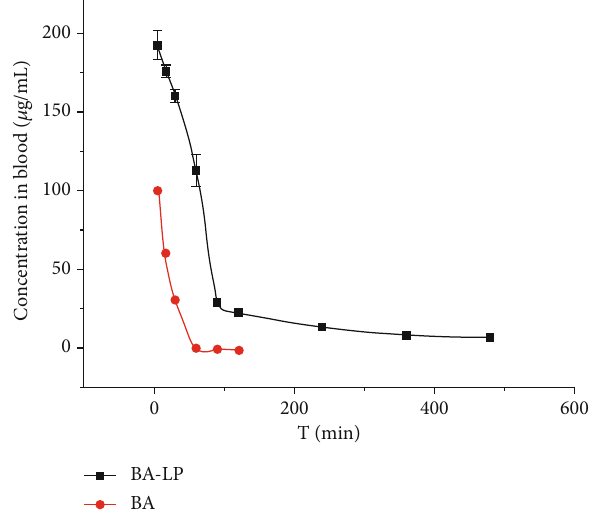
Figure 1: The plasma concentration-time pro fi le of BA after i.v. administration of BA and BA-LP (100mg/kg) in normal mice ( n = 5